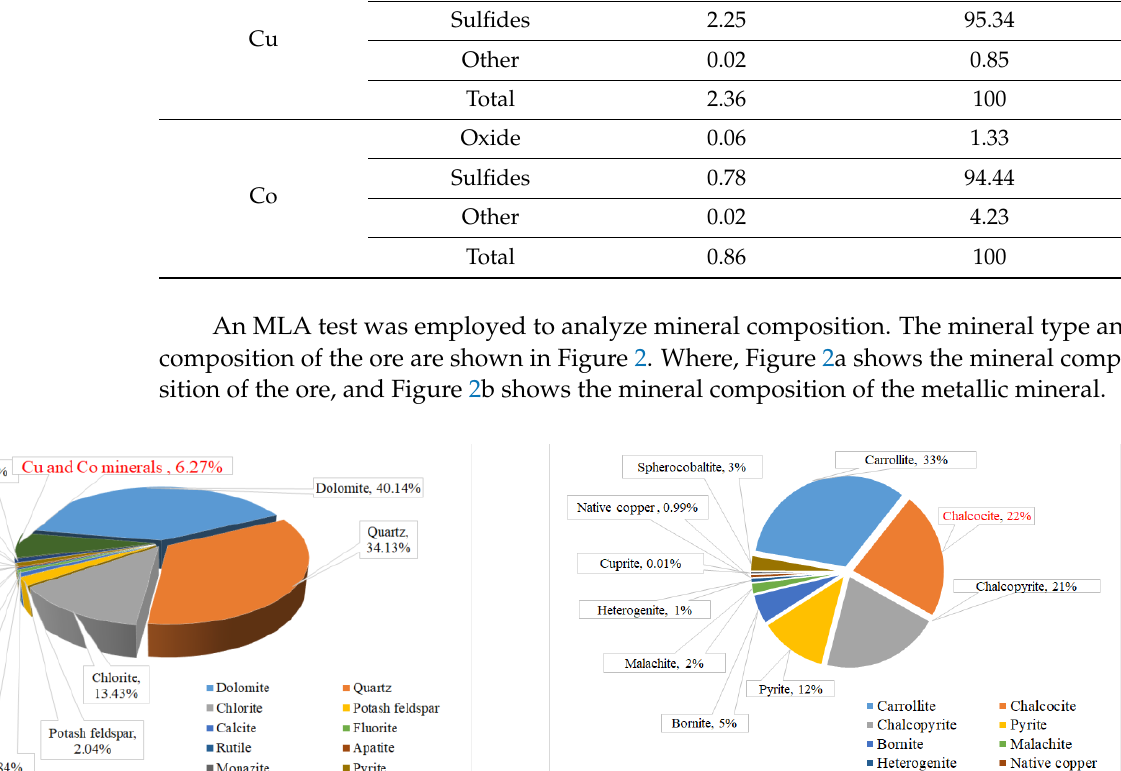
Table 3. The chemical phases of ore.